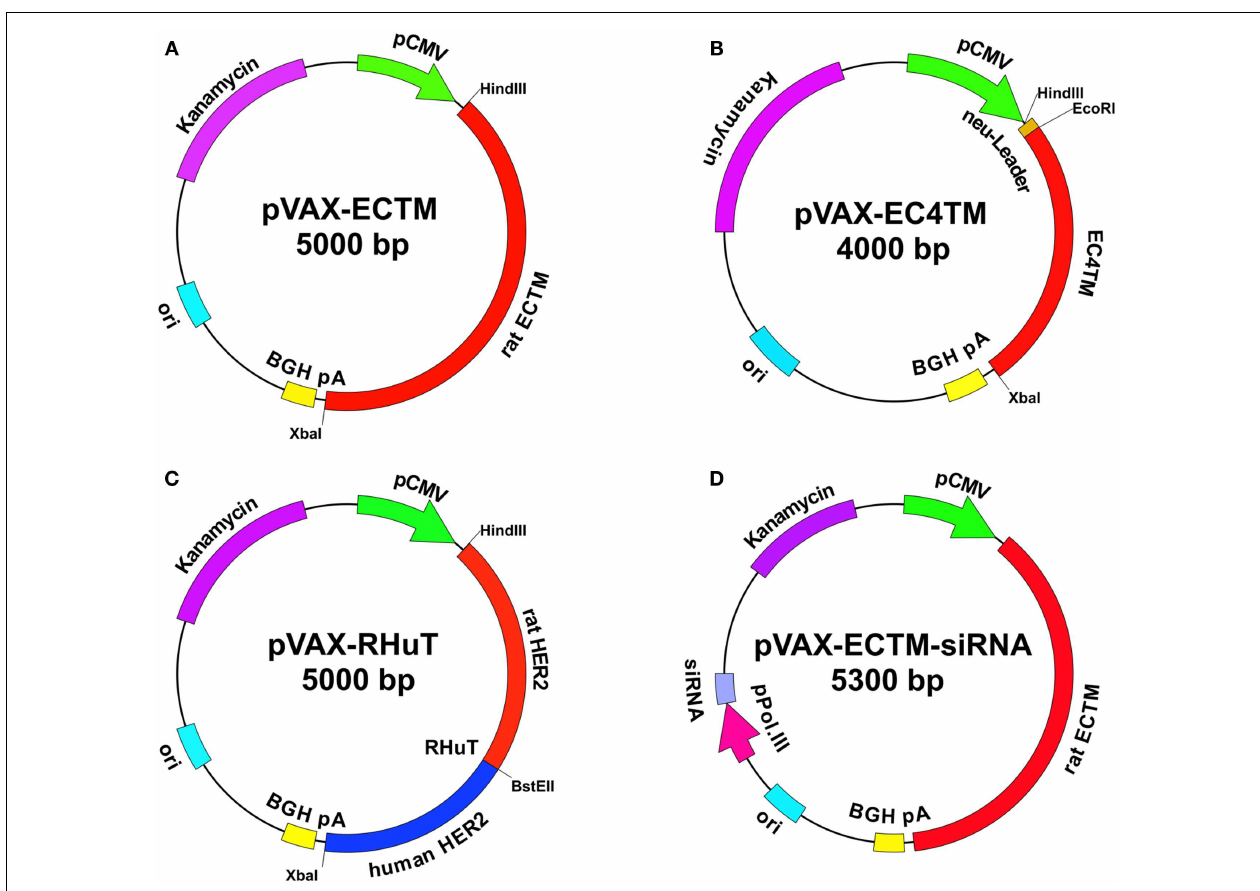
pVAX1 using Eco RI and Xba I restriction enzymes, downstream of the leader sequence that had been previously cloned with Hin dIII and Eco RI. RHuT (C) : rat cDNA that encodes the 410 NH 2 -terminal residues of HER2 was cloned into pVAX1 using Hin dIII and Bst EII restriction enzymes upstream of the human cDNA that encodes the remaining residues of the EC and theTM domains previously cloned using Bst EII and Xba I restriction enzymes. pVAX-EC-TM-siRNA (D) : a silencing module, which generates a short hairpin (sh)RNA under the control of a polymerase III promoter was inserted